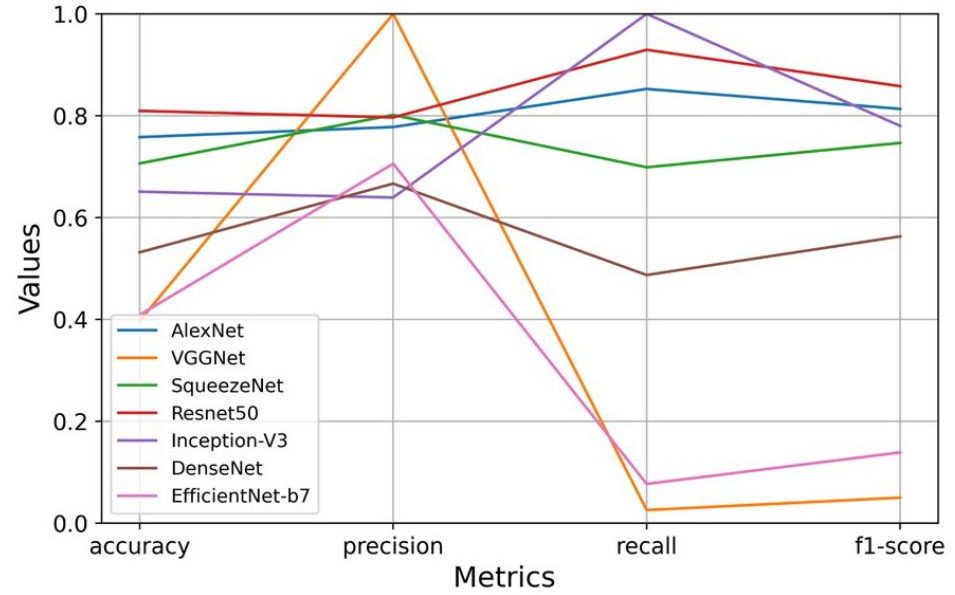
Figure 22. Evaluation of models on